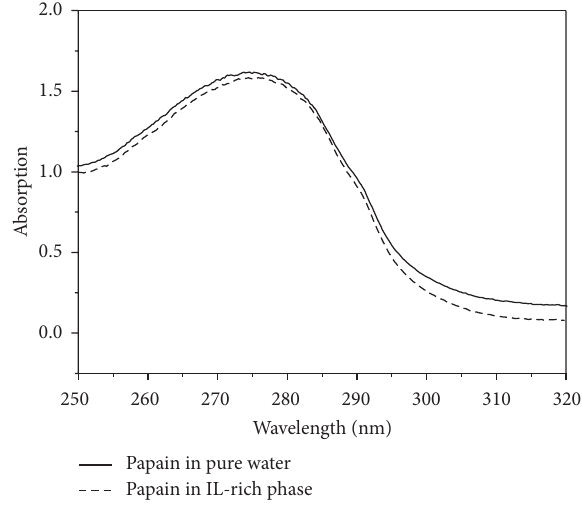
Figure 6: UV spectra of papain in pure water and in [Bmim]Br-rich upper phase.